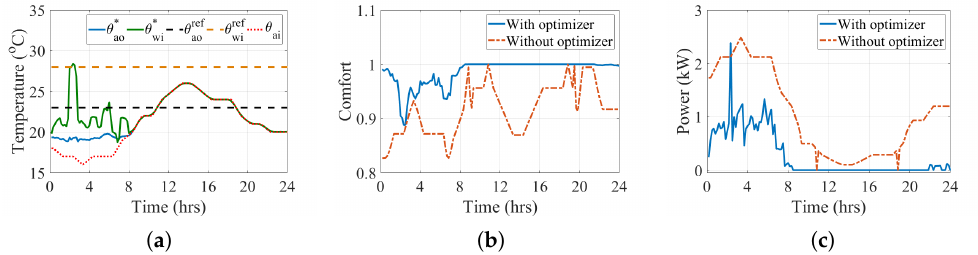
Figure 11. System performance during typical warm day in Auckland (first day of January). ( a ) Optimized set-points. ( b ) Comfort level comparison. ( c ) AHU system power consumption for temperature control.